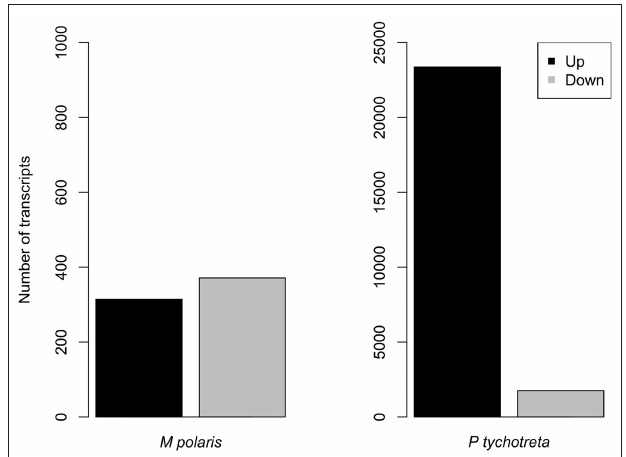
FIGURE 3 | Number or genes differentially expressed in M. polaris and P. tychotreta . The threshold for significant differential expression is defined as a 2 log 2 fold-change in expression in response to changes in nutrient condition Note difference in scales.